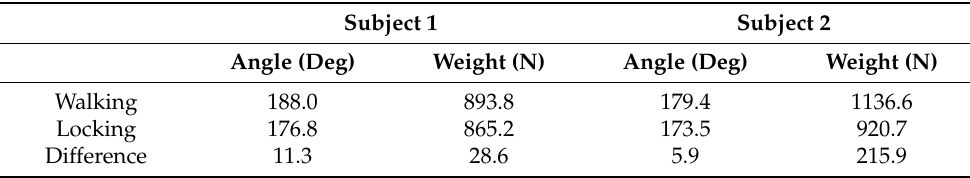
Table 5. Results of flexion angle and max vertical GRF during walking and microprocessor locking trials. Difference shows the resulting difference between values of the two different trials.